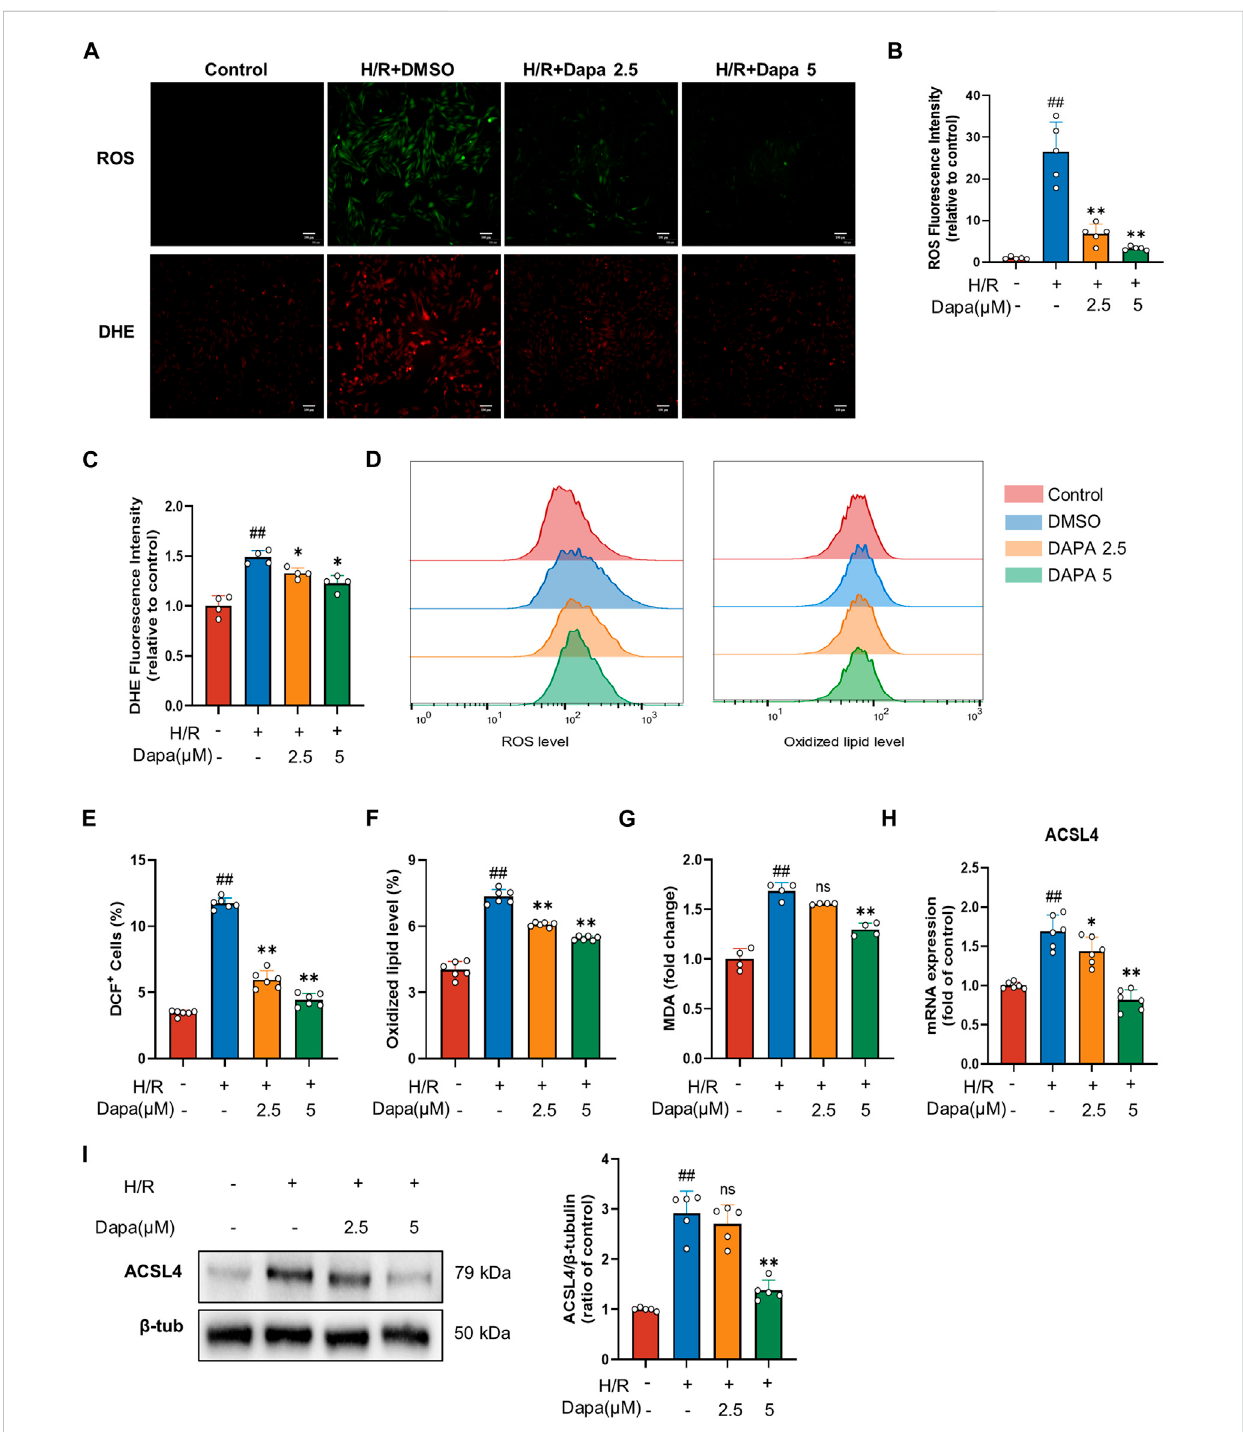
FIGURE 2 Dapagli fl ozin ameliorates H/R-induced ROS and lipid peroxidation in H9C2 cells. (A – C) Representative fl uorescence images of ROS and DHE staining (scale bar, 100 μ M) and quanti fi cation of fl uorescence intensity ( n = 4, 5 per group). (D – F) The levels of lipid ROS were captured by using 2,7- dichloro fl uorescein diacetate, oxidized lipids were captured by using C11 BODIPY and measured by fl ow cytometry in H9C2 cells pretreated with or withoutDAPA( n =6pergroup). (G) MDAcontent wasassayedbyacommercial kit( n =4pergroup). (H) ThemRNAlevelofACSL4wasmeasuredby qPCR( n =6pergroup). (I) Theproteinlevelwasmeasuredbywesternblottingaftertreatmentwith2.5or5 μ MDAPA( n =5pergroup).Dataareexpressed as mean ± SD; One-way ANOVA followed by Tukey ’ s correction for post hoc multiple comparisons or Dunnett ’ s multiple comparison tests; # p < 0.05, ## p < 0.01 vs Control group; * p < 0.05, ** p < 0.01 vs